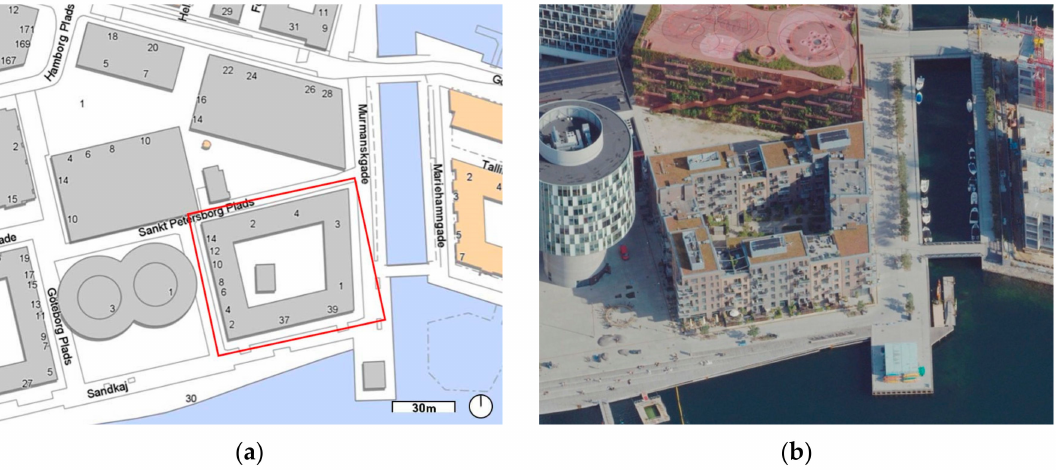
Figure 13. Overview of case study 3: ( a ) map with location of the lot [41]; ( b ) rial view of the building complex